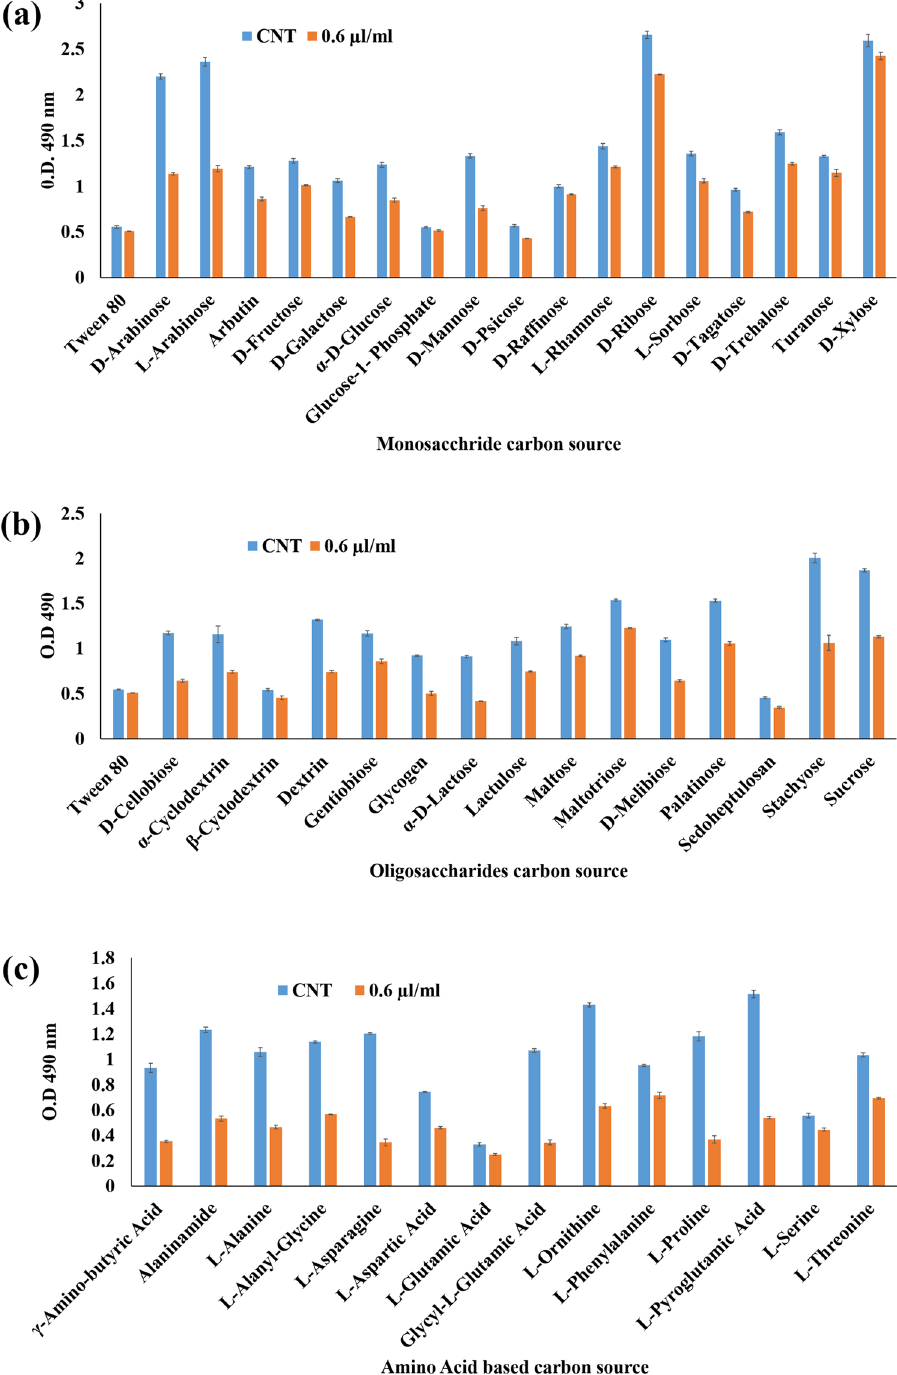
Figure 3. Carbon sources utilization pattern of A. flavus exposed to ZOEO ( a ) monosaccharide C-sources; ( b ) disaccharide C-sources; and ( c ) amino-acid based